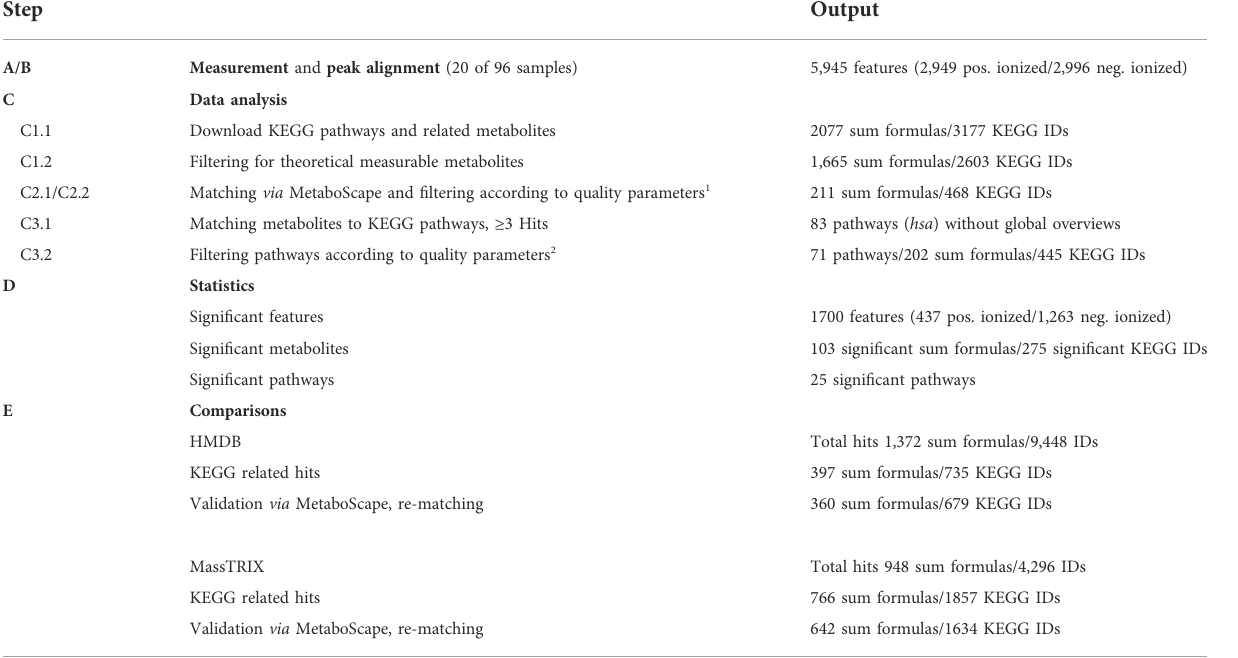
TABLE 2 Overview of results of the work fl ow for the metabolomics approach; subdivided according to steps and their respective